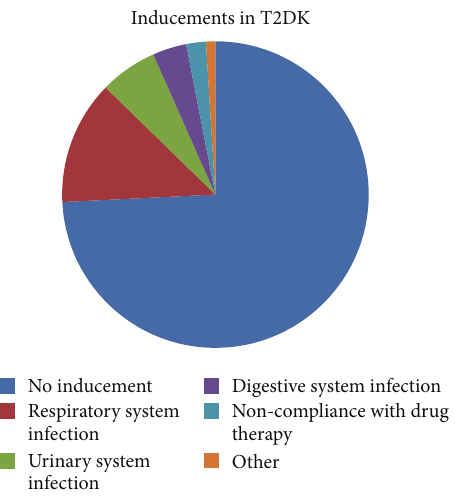
Figure 1: Inducements in type 2 diabetes with